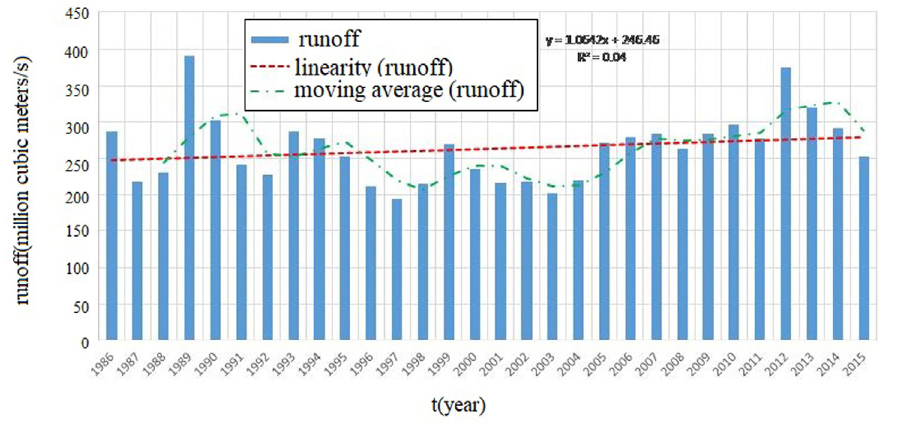
Figure 9. Changes in water surface runoff in irrigation areas other than the mainstream of the Yellow River.